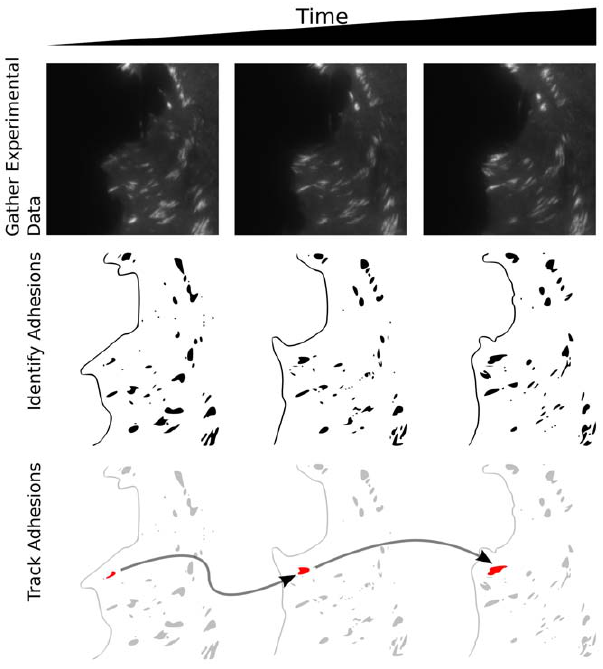
Figure 1. Automating the analysis of focal adhesion images requires a multi-stage pipeline. The first row shows several representative images of fluorescently labeled Paxillin using TIRF microscopy. In the second row, a cartoon depiction of the segmented adhesions and the cell edge are shown. Identification of the adhesions in each image allows a set of characteristic morphological and fluorescence intensity-based features to be extracted. The third row shows a single adhesion (highlighted in red) being tracked through the short sample time course. The properties of each adhesion are tracked over time, allowing the large scale dynamics of FA to be determined.